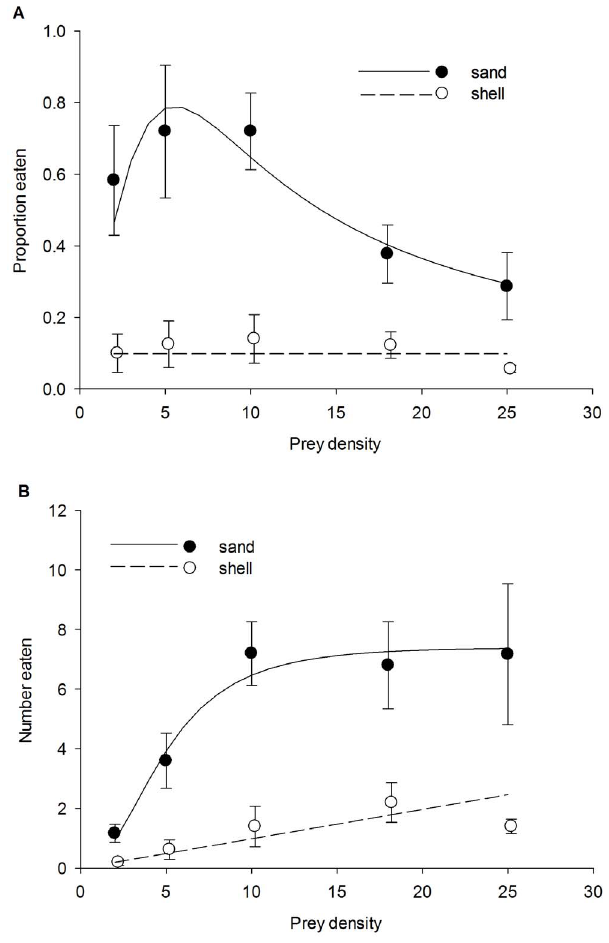
Figure 1. Functional response of year-1 blue king crabs ( P. platypus ) to year-0 blue king crabs density in sand (closed circles) and shell (open circles) habitat: (A) proportional predation and (B) number of prey crabs eaten. Points are the average ( 6 SE) at each density and are offset slightly. Lines represent the best fit functional response model for each habitat. Parameter estimates ( 6 SE) for sand are: b =0.039 (0.023), c = 2 0.068 (0.19), T h =0.84 (0.19), and for shell are: r =0.016 (0.003).